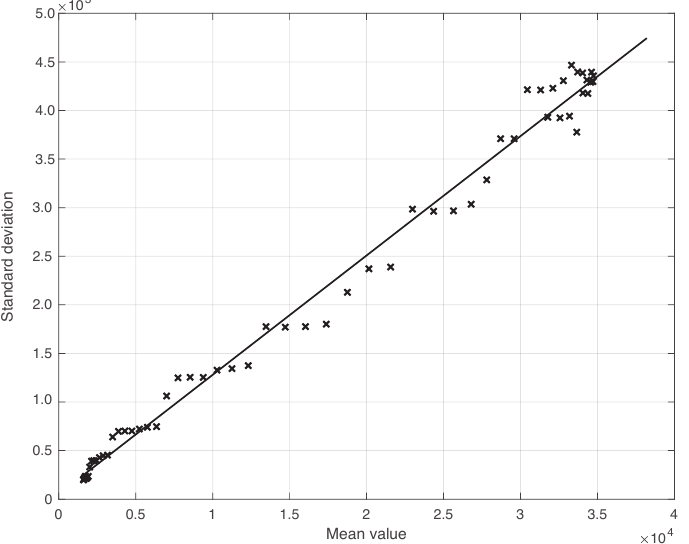
Figure 2. Standard deviation of the local fluctuations of a real SARS-CoV-2 Italian positive test sequence from 21 September to 20 November 2020, illustrated in Figure 1, as a function of their expected value. The continuous line represents the best fit with a degree 2 polynomial model, which in this case is reduced to a straight line.